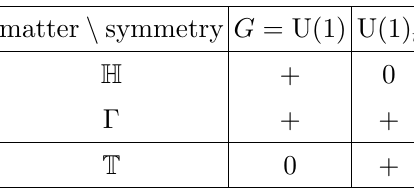
Figure 5 . The brane constructions of the Neumann b.c. ( Dirichlet b.c. D for twisted